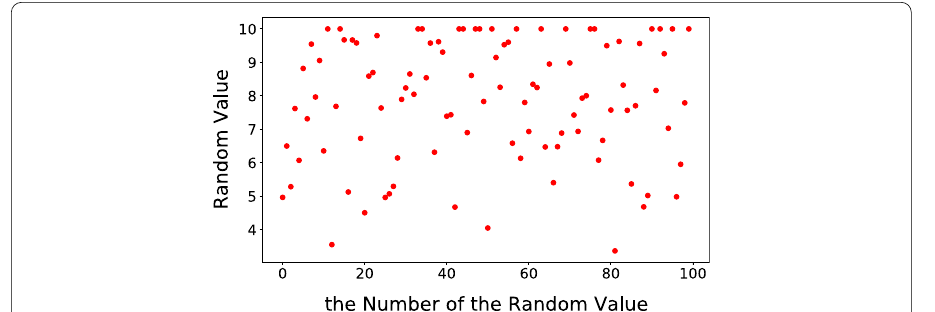
Fig. 5 The first 100 values of the quality of the task